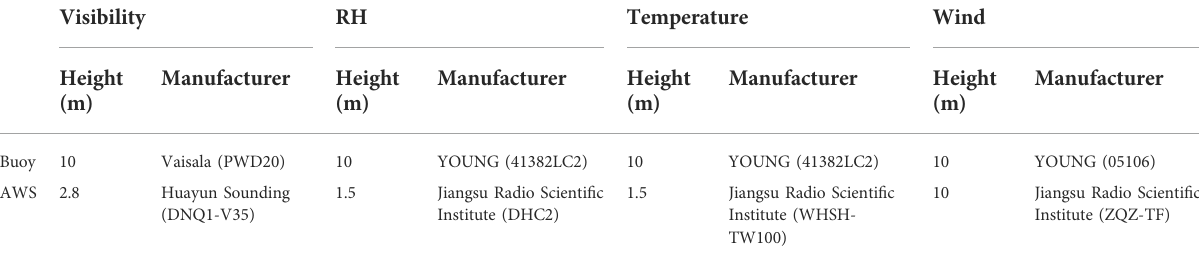
Table 1. The three AWSs on islands provide the same measurements as the buoys.